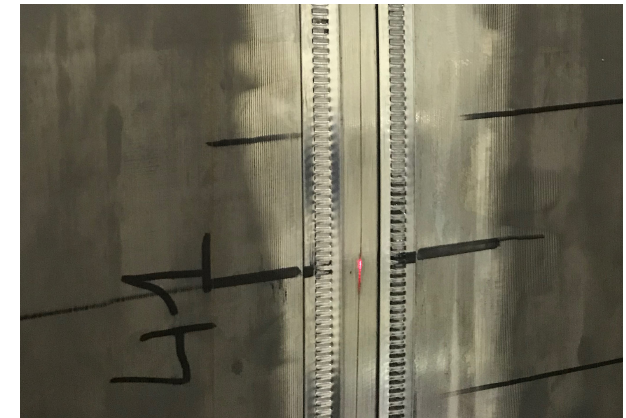
Figure 5. Detail view of an optical fiber where a Bragg grating is illuminated in red